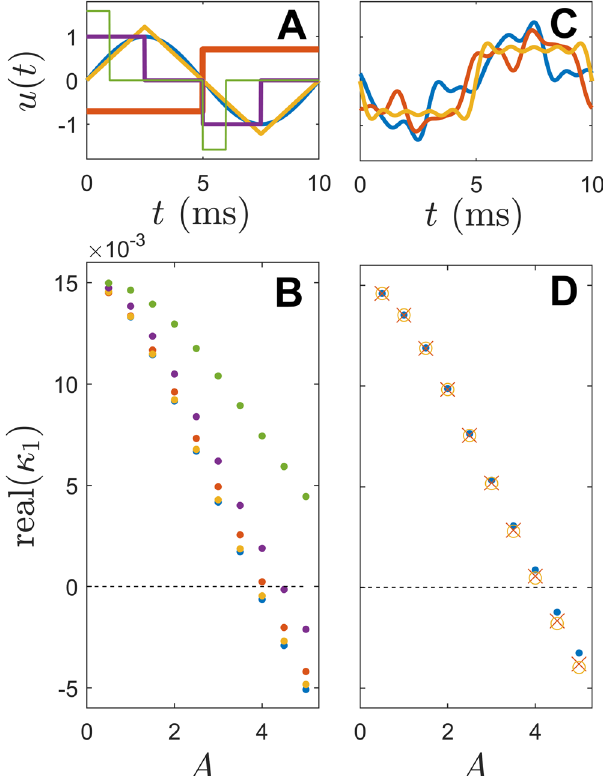
Figure 7. Comparisons between different stimulus shapes and resulting changes to Floquet exponents. In panel A, five different stimulus shapes (each with equal energy consumption) are shown. Each of these stimuli are multiplied by a given amplitude, A , and the resulting values of κ 1 are shown in panel B. Colors of the individual dots correspond to the stimulus colors shown in the panel above. Similarly, three stimuli with identical + a b for all k are shown in panel C. Markers of corresponding color in panel D illustrate that the resulting changes to κ 1 are nearly identical for each stimulus. As expected, the sinusoidal forcing provides the maximum change in the Floquet multiplier at a given